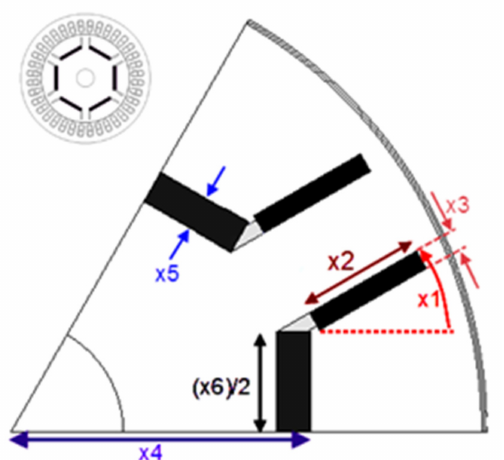
Figure 3. Proposed structure of the IPMSM and optimization variables.